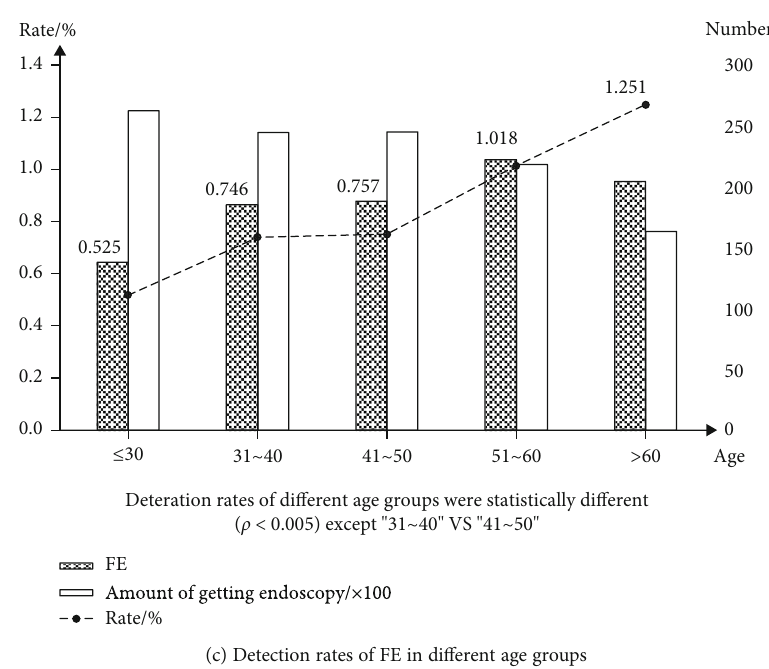
Figure 1: Detection rates of FE in di ff erent time spans and age